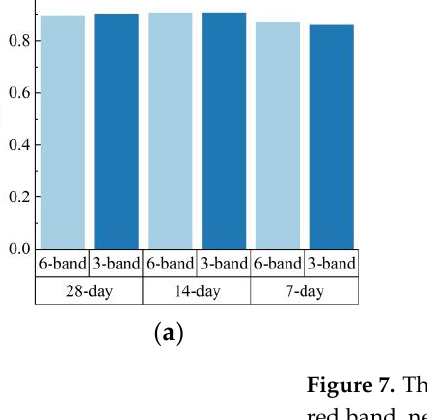
Figure 6. Rice extraction results of test area in 2020 for U-net and Random Forest classifiers with different time interval scenarios. ( a ) Overall accuracy; ( b ) F1 scores.